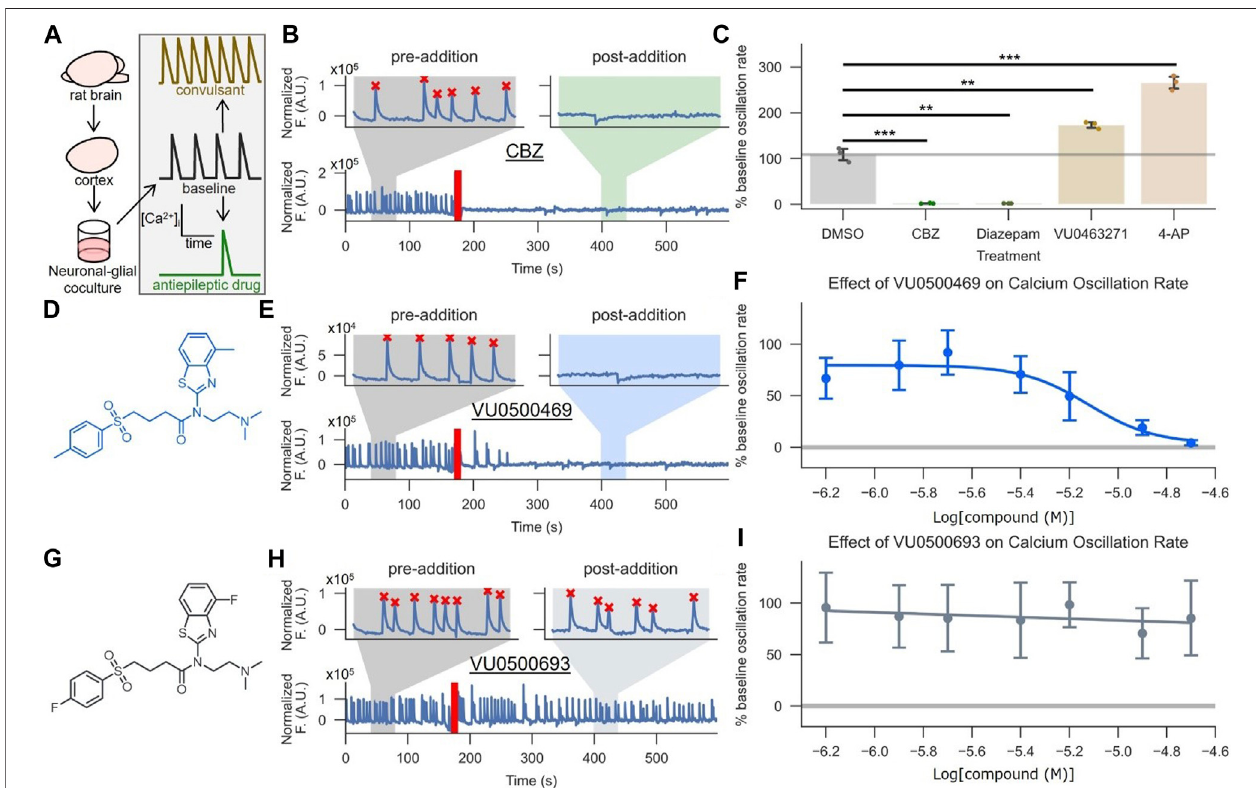
FIGURE 5 | VU0500469 inhibits seizure-like, synchronous Ca 2+ oscillations in cultured rat cortical neurons. (A) Cartoon description of the synchronous Ca 2+ oscillation assay, which uses neuronal Ca 2+ oscillations from high density neuronal-glial cocultures to model epileptiform activity. (B,C) Validation of the synchronous neuronal Ca 2+ oscillation assay ’ s ability to report anti-epileptic and KCC2-dependent activity. (B) Example Ca 2+ oscillation trace treated with the antiepileptic drug carbamazepine (CBZ). Segments before and after compound addition are highlighted to better show neuronal Ca 2+ oscillations in the absence and presence of compound,respectively.Thetimepointofcompoundadditiondenotedbytheredline.Oscillationsrecognizedbyaspikecountingalgorithmaremarkedbyared “ X. ” (C) Quanti fi ed % pre-addition oscillation rate for CBZ, the GABA A positive allosteric modulator diazepam, vehicle control, the convulsant 4-AP, and the KCC2 inhibitor VU0463271 ( n = 3). (D – F) VU500469 dose-dependently prevents seizure-like Ca 2+ oscillations. (D) VU0500469 structure. (E) Example trace treated with 20 μ M VU0500469, annotated as in (B) . (F) Dose-dependent effect of VU0500469 on Ca 2+ oscillation rate ( n = 10). (G – I) VU0500469, a structurally related analog of VU0500469withoutsigni fi cantactivityintheCl − fl uxassay,doesnotaffectseizure-likeCa 2+ oscillations. (G) VU0500469structure. (H) Exampletracetreatedwith20 μ M VU0500469, presented as in (B) . (I) Dose-dependent effect of VU0500469 on % pre-addition oscillation rate. Error bars represent SD. ( n = 10). Statistical signi fi cance calculated by one sample t-test (6B, DMSO v. diazepam) and Welch ’ s t-test for all other samples: ** = p < 0.01, *** = p <